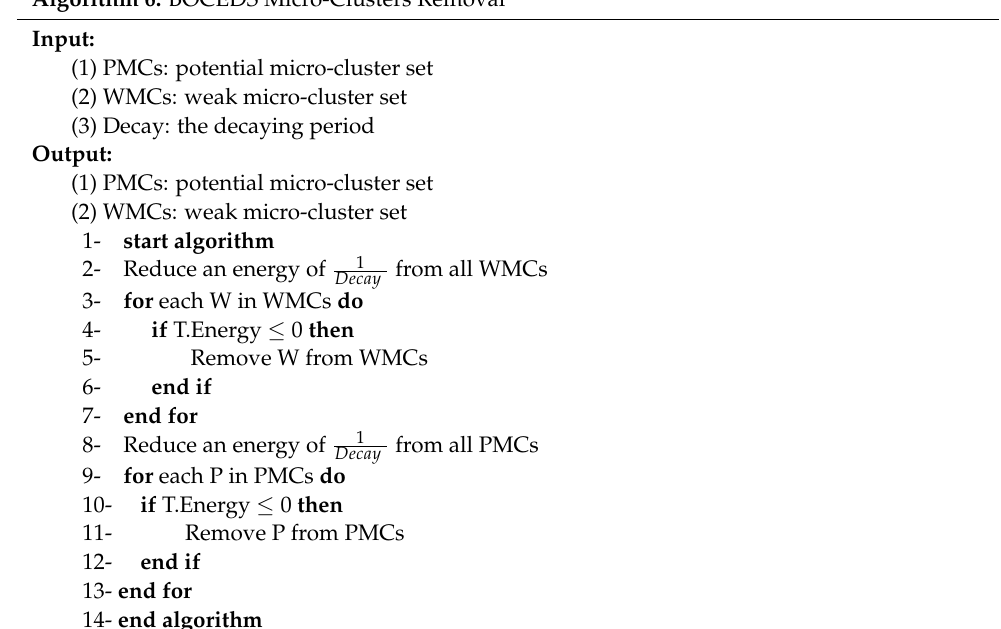
Algorithm 6: BOCEDS Micro-Clusters